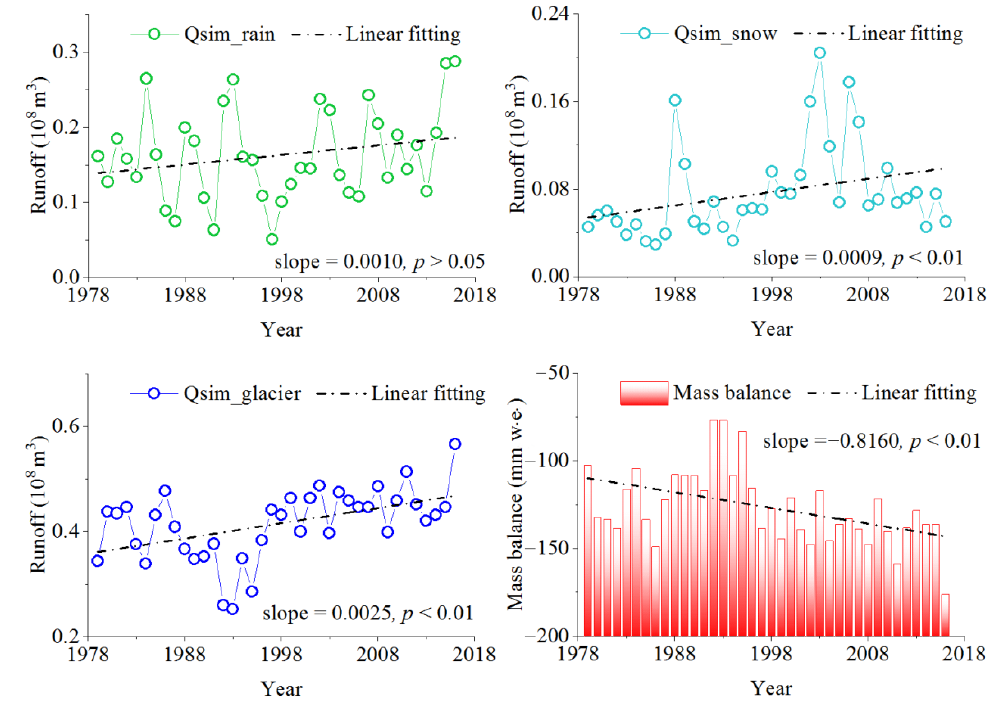
Figure 8. Variation of the simulated rainfall runoff (Qsim_rain), simulated snowmelt runoff (Qsim_snow), simulated glacial runoff (Qsim_glacier) and glacier mass balance from 1979 to 2016.